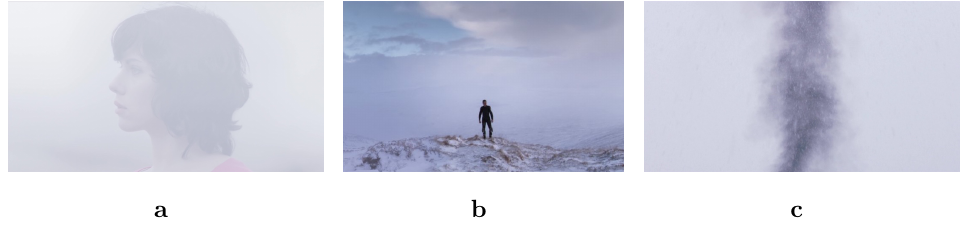
Figure 3: Echoes of eyes, from Under the Skin directed by Jonathan Glazer. 2013; London: BFI & Film 4.